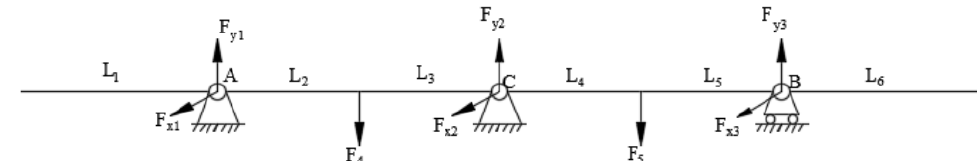
Figure 5. Force diagram of the pin.